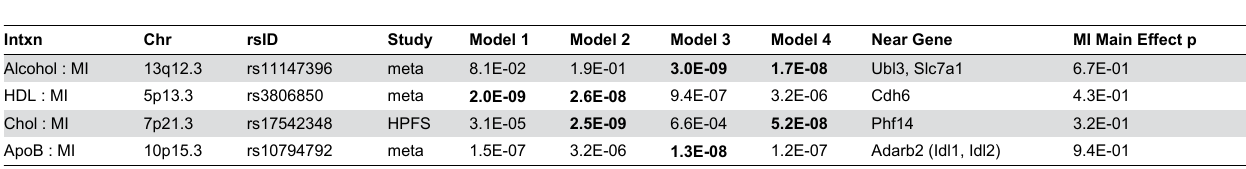
Table 4. Gene: environment and gene: intermediate interactions with incident MI reaching genome-wide significance.